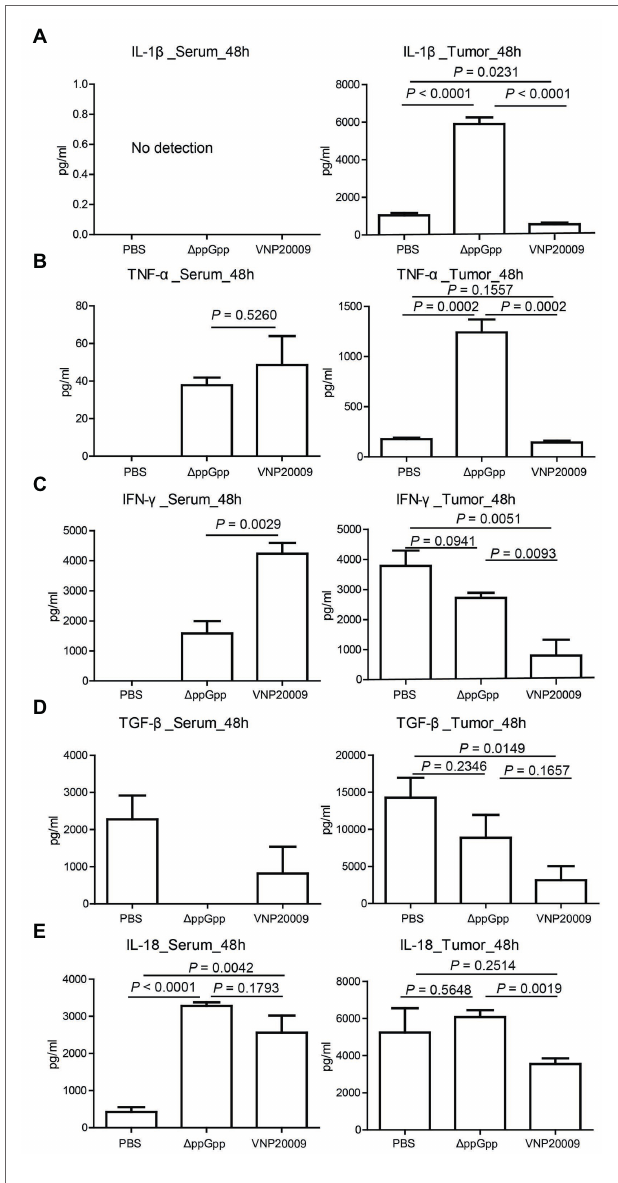
FIGURE 4 | Cytokine production in vivo post-bacterial infection. (A) Determination of IL-1 β expression in serum and tumor tissues of MC38- bearing mice at 48 h after bacterial injection ( n = 4, p < 0.0001) between Δ ppGpp and VNP20009 or PBS in tumor. (B) Expression of TNF- α in serum and tumor tissues of tumor-bearing mice after 48 h of bacterial injection ( n = 4, p = 0.0002) between Δ ppGpp and VNP20009 or PBS in tumor. (C) IFN- γ expression levels in serum and tumor tissues, p = 0.0029 between Δ ppGpp and VNP20009 in serum, p = 0.0015 between PBS and VNP20009 in tumors, and p = 0.0093 between Δ ppGpp and VNP20009 in tumors. (D) TGF- β in serum and tumor tissues at 48 h after bacterial injection, n = 4, p = 0.0149 between PBS and VNP20009. (E) IL-18 levels in serum and tumor tissues 48 h after bacterial injection, n = 4, p < 0.0001 between PBS and Δ ppGpp, p = 0.0042 between PBS and VNP20009 in serum, and p = 0.0019 between Δ ppGpp and VNP20009 in